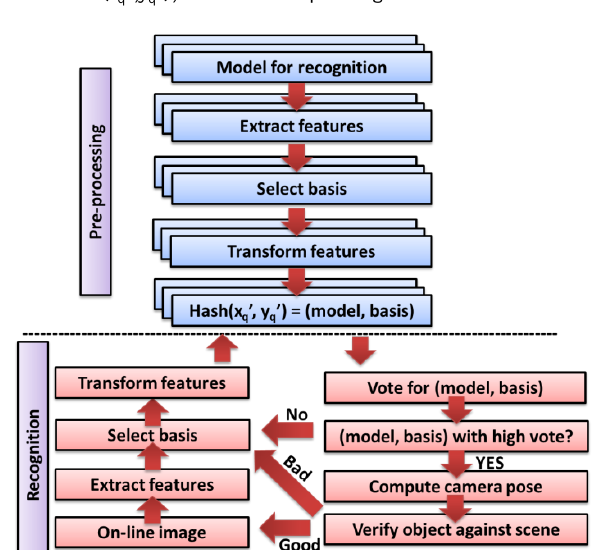
Figure 4. Flow chart for the geometric hashing algorithm. (modified from Lamdan et al.,